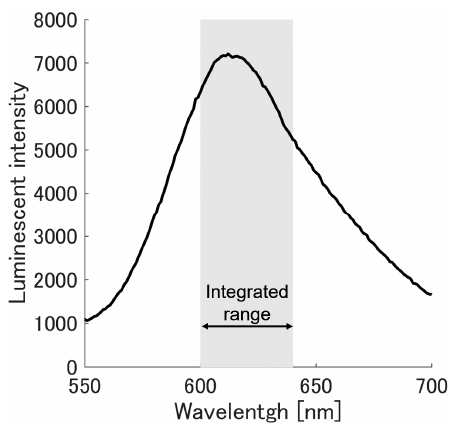
Figure 4. Representative luminescent spectrum of the PC-PSP at P ref = 100 kPa, and T ref = 303 K.